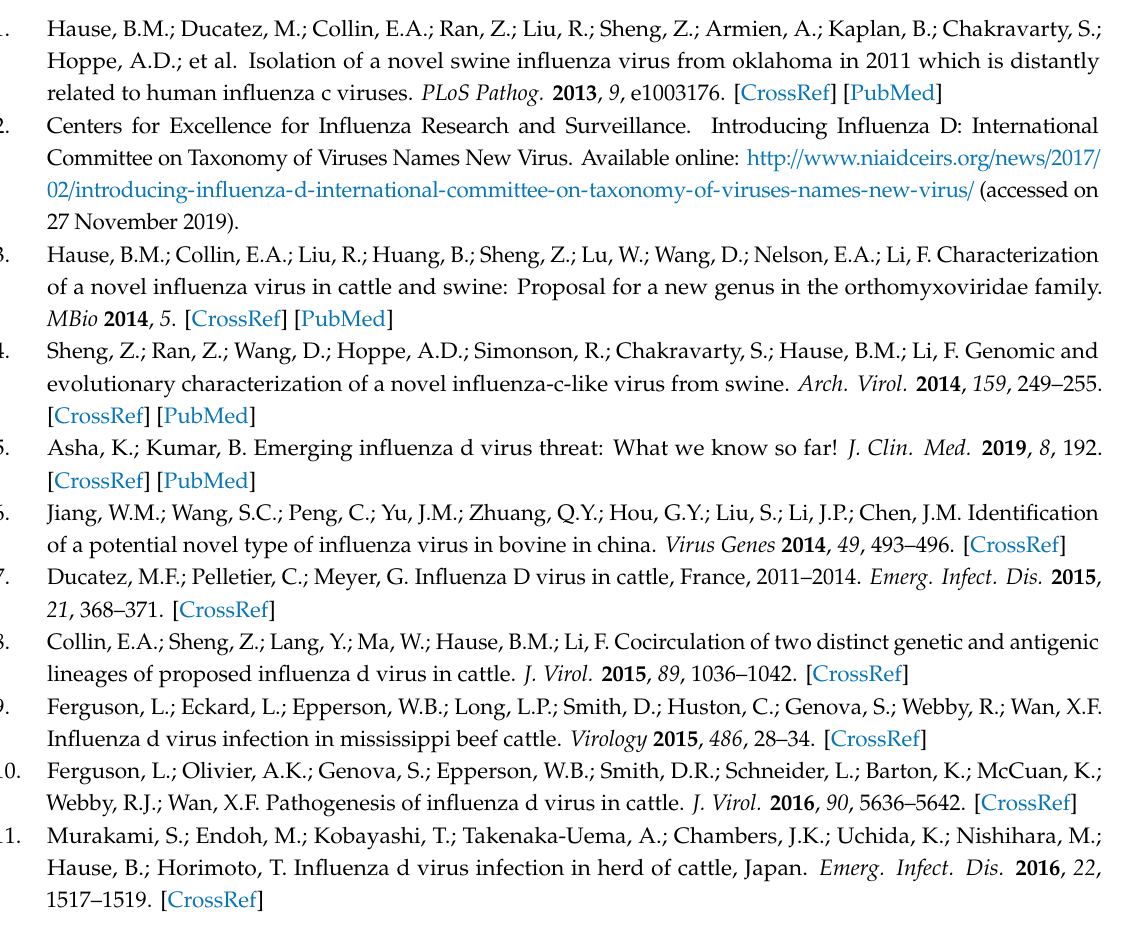
Figure S1: VN vs. HI, normalized proportions and trend lines for the titre class ≥ 1:10, Table S1: Serum samples collected in Italy from 2005 to 2017, Table S2: Results of the multiple proportion test among years, Table S3: Multiple comparisons of proportions of positive titres ( ≥ 1:10, ≥ 1:20) for HI and VN assays along the period